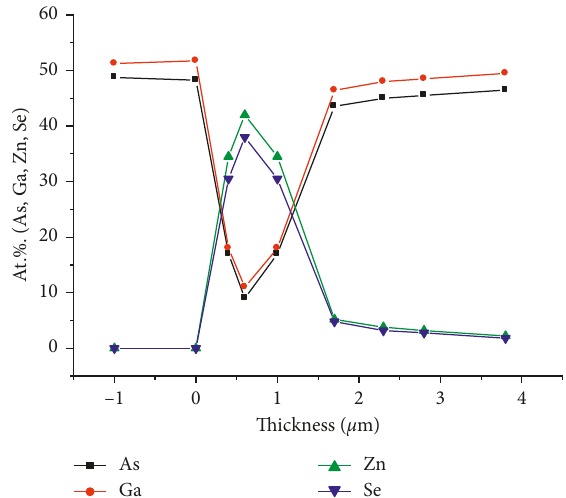
the epitaxial layer of the solid solution (GaAs) 1 − x (ZnSe) x .